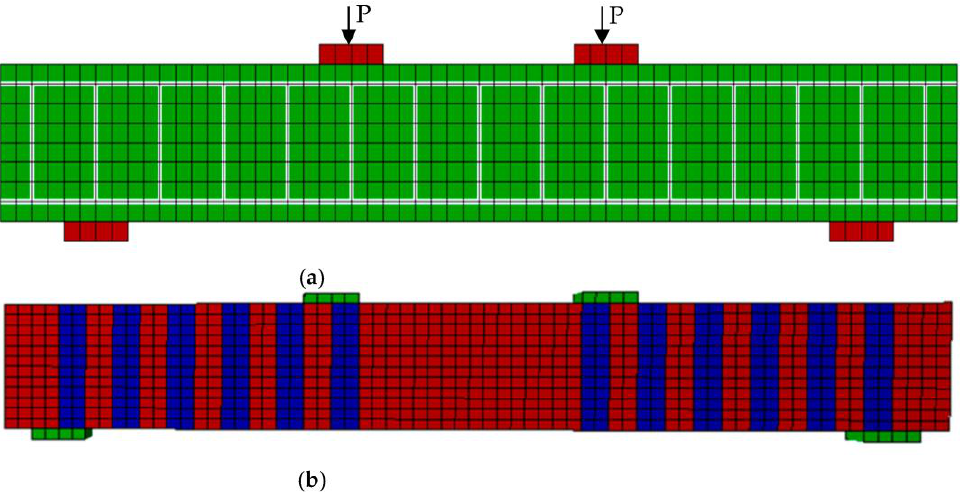
Figure 17. Typical Two-Dimensional View of the Generated Finite Element Models: ( a ) Typical Con- trol Specimen; ( b ) Typical Specimen Strengthened with FRP Strips. Control Specimen; ( b ) Typical Specimen Strengthened with FRP